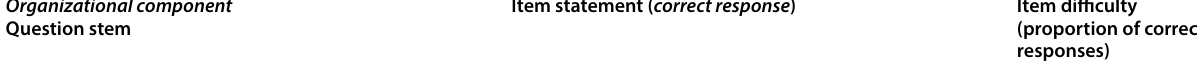
99) within each organizational =